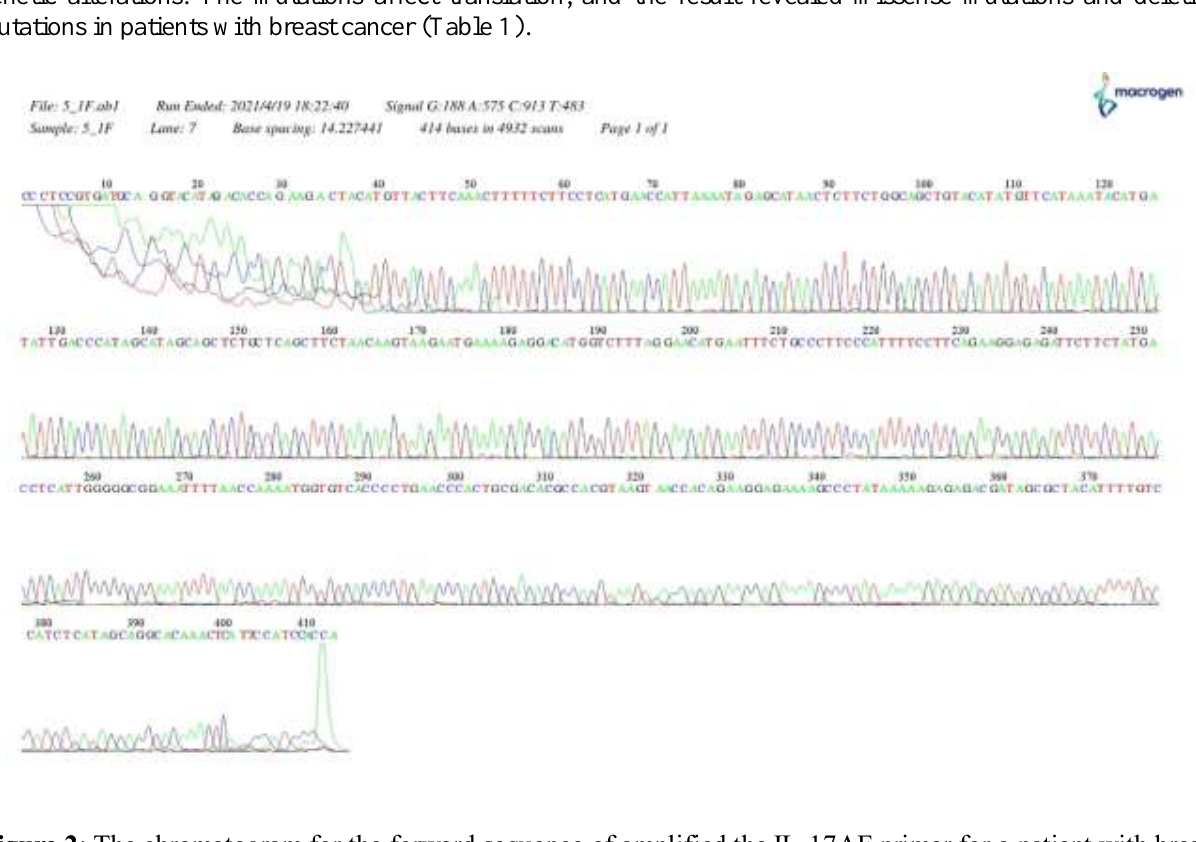
Figure 2 : The chromatogram for the forward sequence of amplified the IL-17AF primer for a patient with breast cancer by DNA